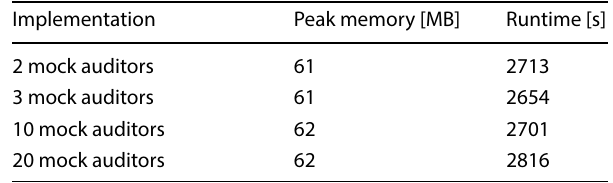
Table 3 The effect of early pruning Implementation